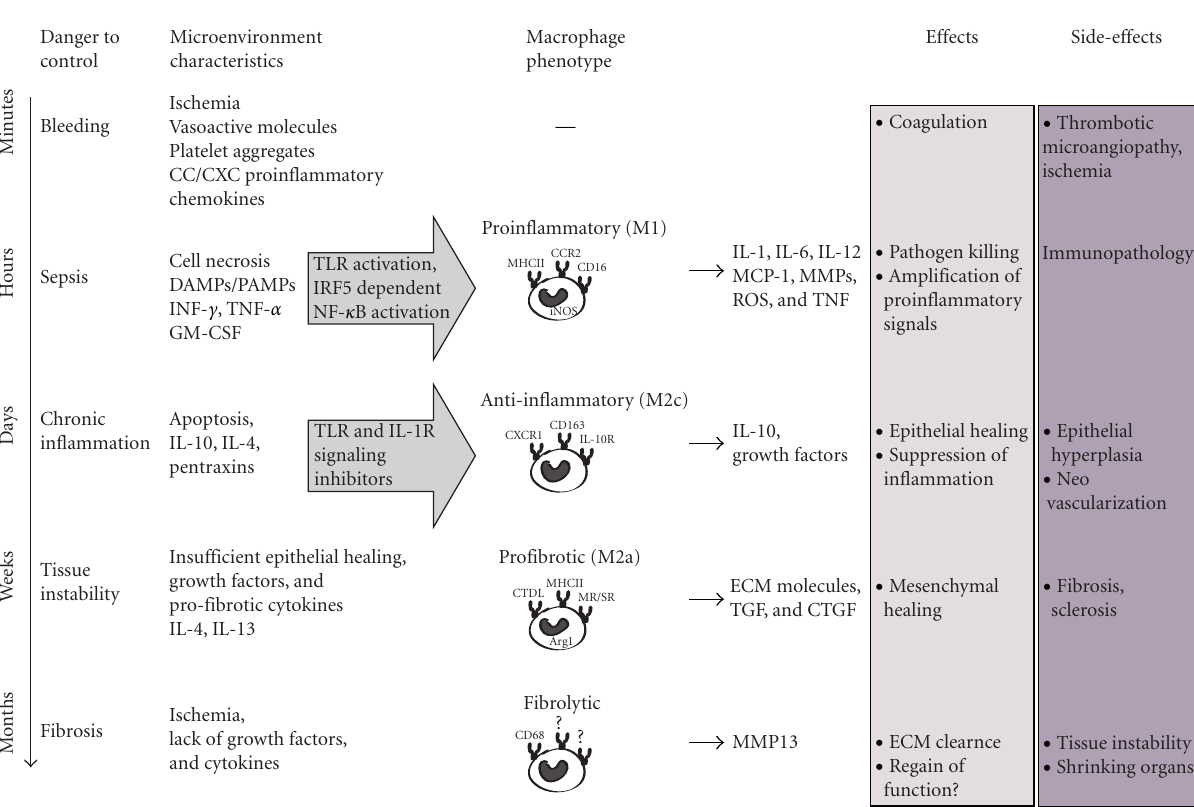
Figure 2: Tissue microenvironments and predominant macrophage phenotypes. Danger control involves several response programs that operate from seconds to months after injury. In each of these phases, the tissue environment shapes the phenotype of resident and infiltrating mononuclear phagocytes, which then enforce the particular environment in a feed-forward loop. Their potential to amplify inflammation, healing, or scaring has consequences on the tissue that may be beneficial or unfortunate in terms of rapidly regaining homeostasis and full function of the organ. This illustrates that the evolutionary programs of danger control are not perfect in all settings, but the fact that they were positively selected during evolution allows only one interpretation: they obviously represented the best compromise between the di ff erent needs of multicellular organisms. Where these programs cause malfunction, also mononuclear phagocytes contribute to the “disease” process. TLR: Toll-like receptor, ROS: reactive oxygen species, and ECM: extracellular